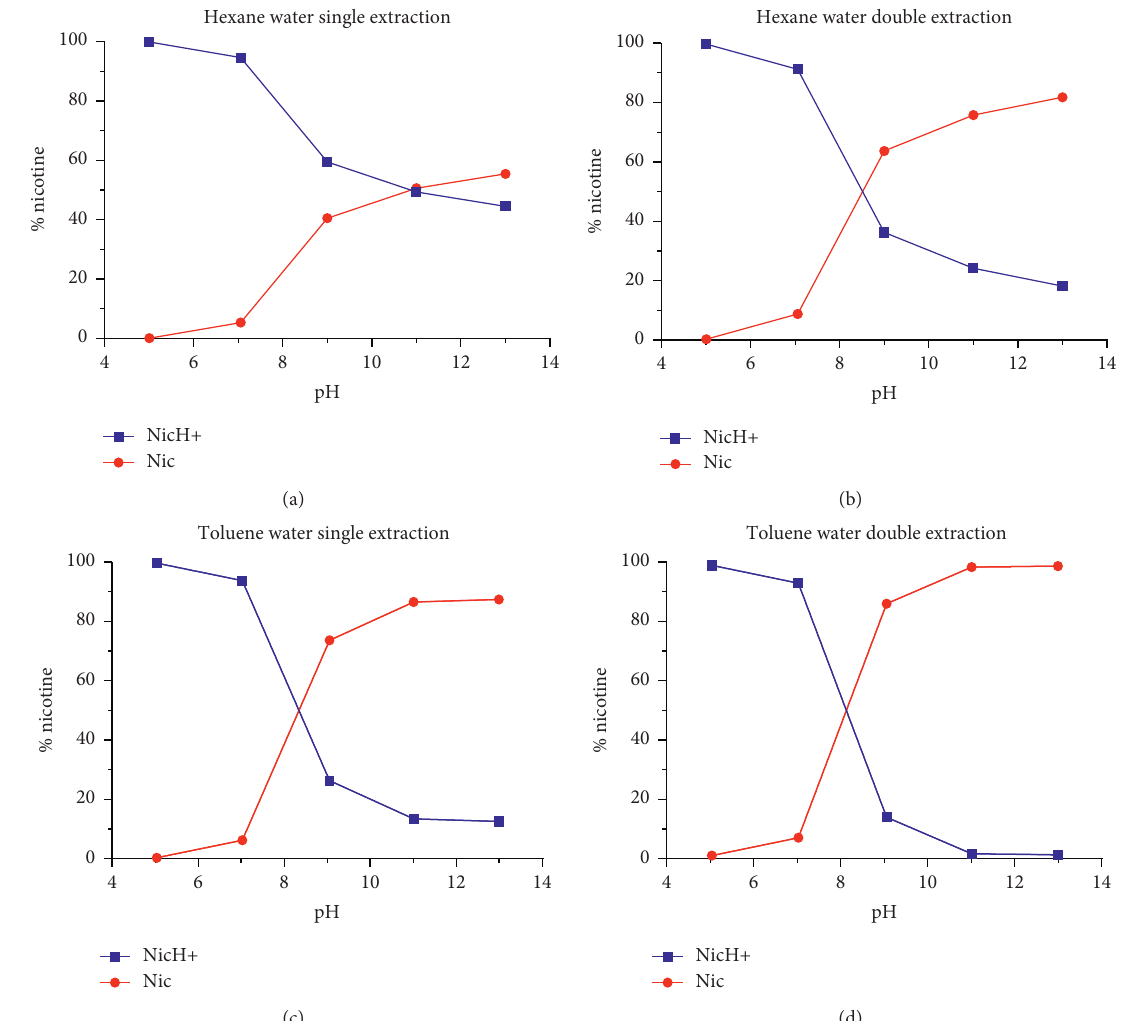
Figure 5: Extraction of free base (Nic) and protonated nicotine (NicH + ) by (a) hexane-water single extraction, (b) hexane-water double extraction, (c) toluene-water single extraction, and (d) toluene-water double extraction. Note. Percent recovery of hexane and toluene extractions is 98.04 ± 1.66 and 97.10 ± 3.47, respectively. All results are in triplicate with RSD < 2.0%. Table 2: Determination of free base nicotine in standard solutions by hexane-water double extraction. % free base nicotine by % experimental free pH % difference Mean % difference Std. Henderson–Hasselbalch equation base nicotine